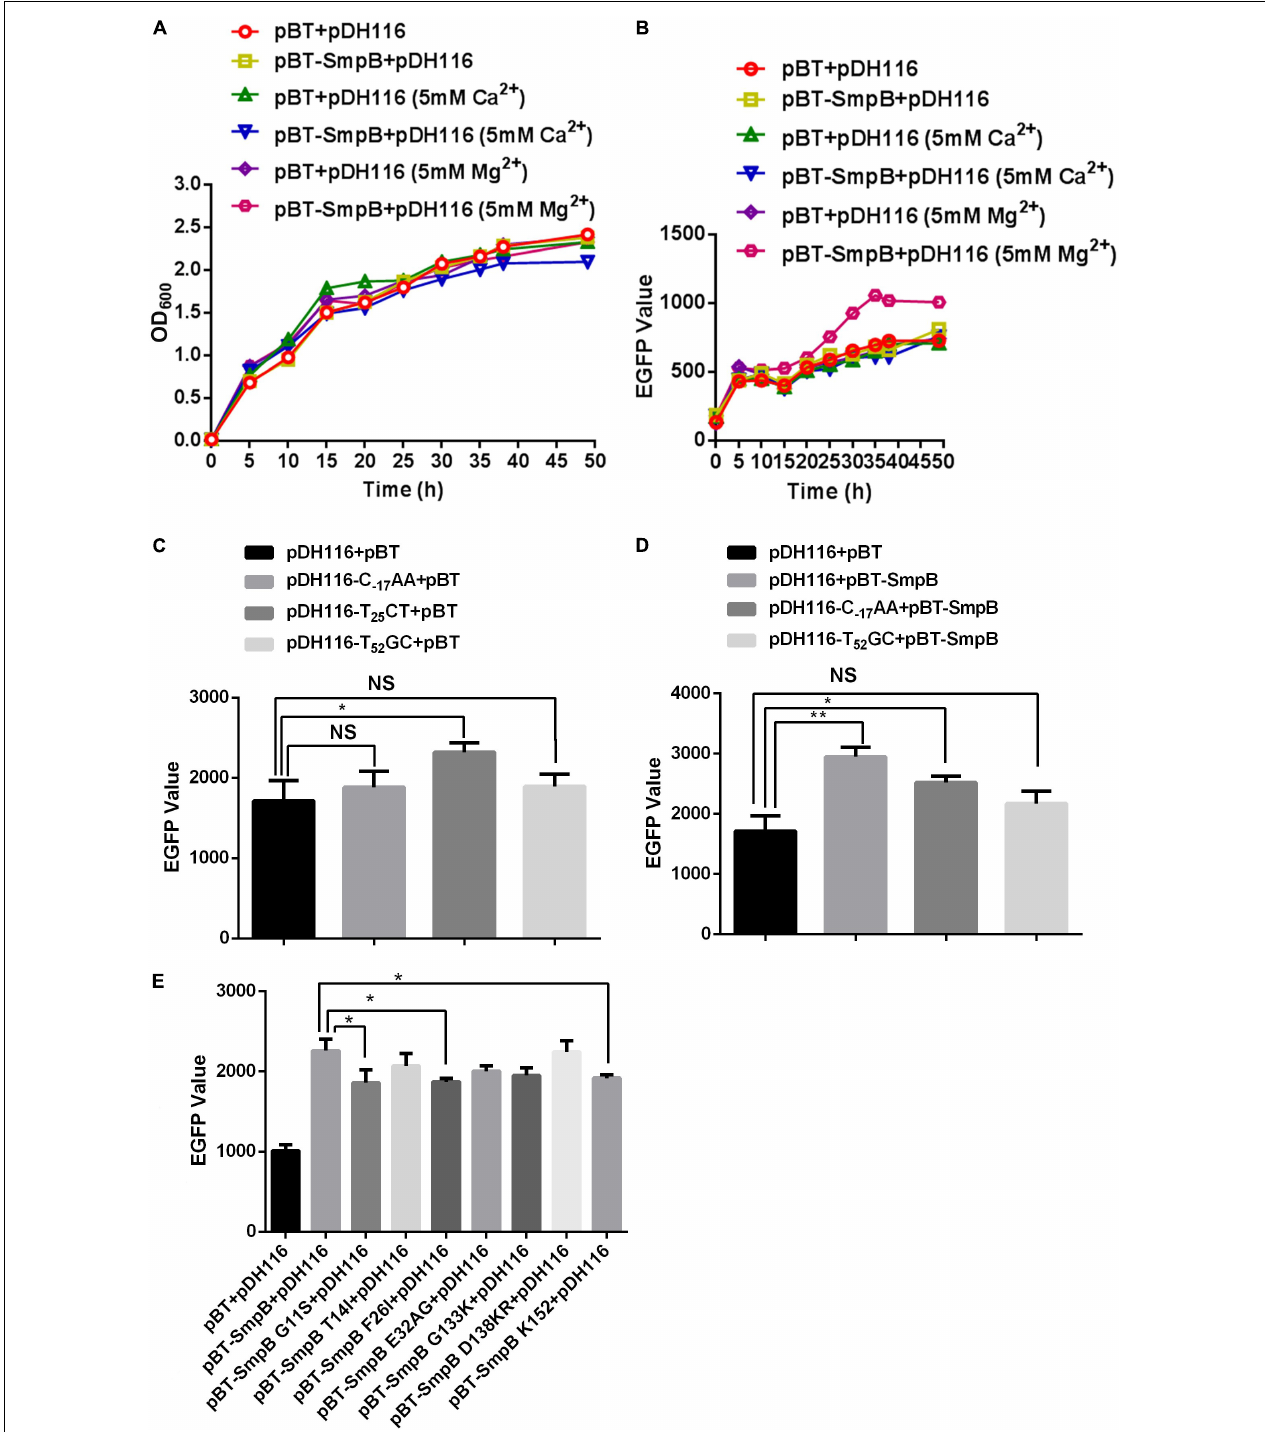
FIGURE 2 | Small protein B regulates the transcription of P ompA positively. (A) Growth measurement of the strain bearing pDH116 when co-transformed with either pBT-SmpB or empty vector pBT. The plasmid pDH116 is endowed with both the promoter of the ompA gene and encoding region of enhanced green fluorescent protein (EGFP). (B) Fluorescence measurement of the strain bearing pDH116 when co-transformed with either pBT-SmpB or empty vector pBT. (C) Promoter activity of the native and mutated pDH116 (pDH116-C - 17 AA, pDH116-T 25 CT, and pDH116-T 52 GC). (D) Effects of SmpB on the expression of the native and mutated pDH116. (E) Identifications of the key amino acid residues in SmpB interacting with pDH116. The “NS” represents “not statistically significant” and “*,**” is significant ( p < 0.05) and extremely significant differences ( p < 0.01), respectively.